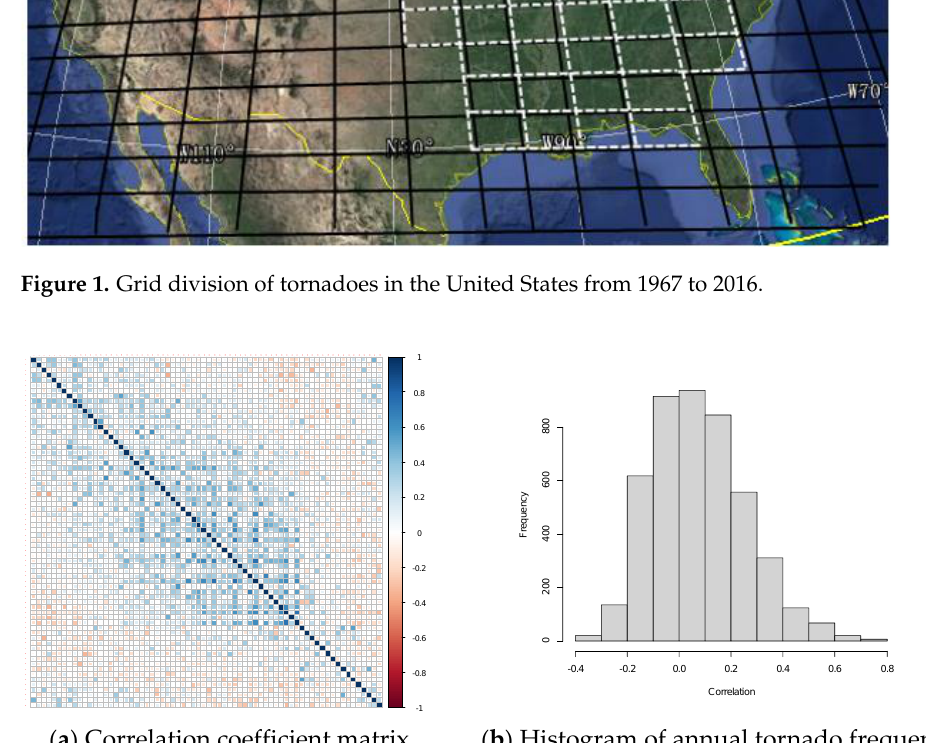
Figure 2. Correlation coefficient matrix and histogram of annual tornado frequency in different grids.